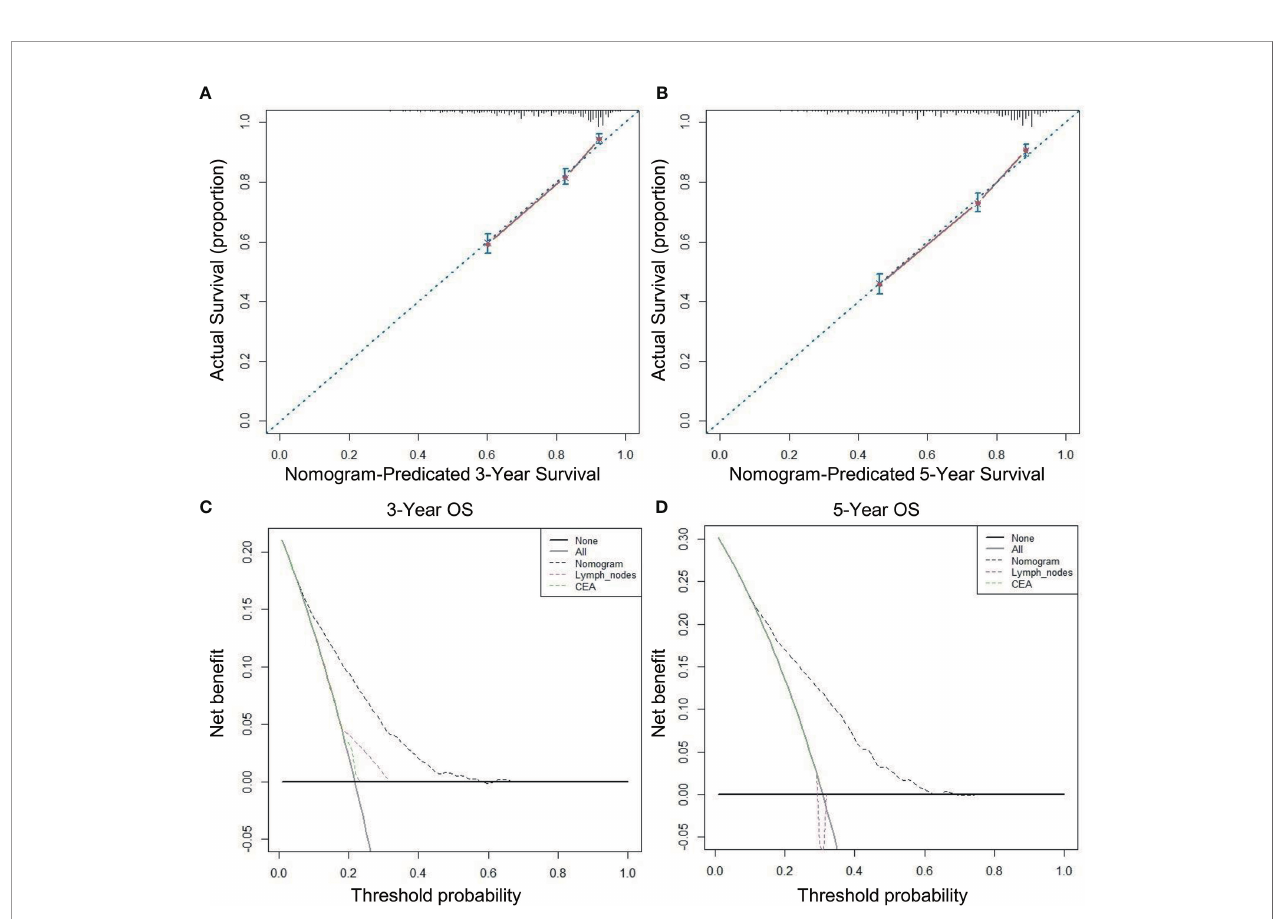
FIGURE 4 | Calibration curves and decision curve for OS prediction: (A) 3-year OS calibration curve in our cohort; (B) 5-year OS calibration curve in our cohort; (C) Nomogram were compared to the lymph nodes retrieved and CEA in terms of 3-year OS in our decision curve analysis; (D) Nomogram were compared to the lymph nodes retrieved and CEA in terms of 5-year OS in our decision curve